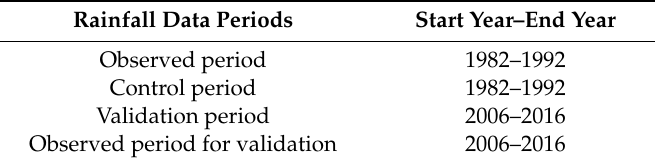
Table 4. Rainfall data period spans used in the advance delta change model.